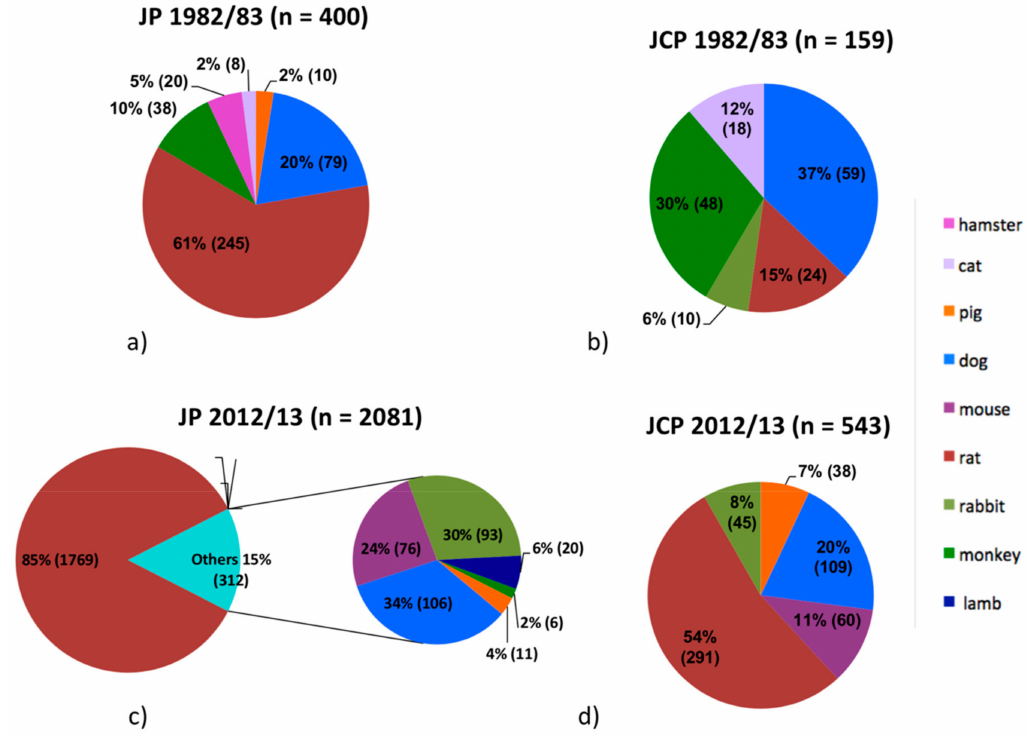
Figure 2. Amount and distribution of di ff erent animal species examined in articles published in JP ( a ) and JCP ( b ) in 1982 / 83, and in JP ( c ) and JCP ( d ) in 2012 /